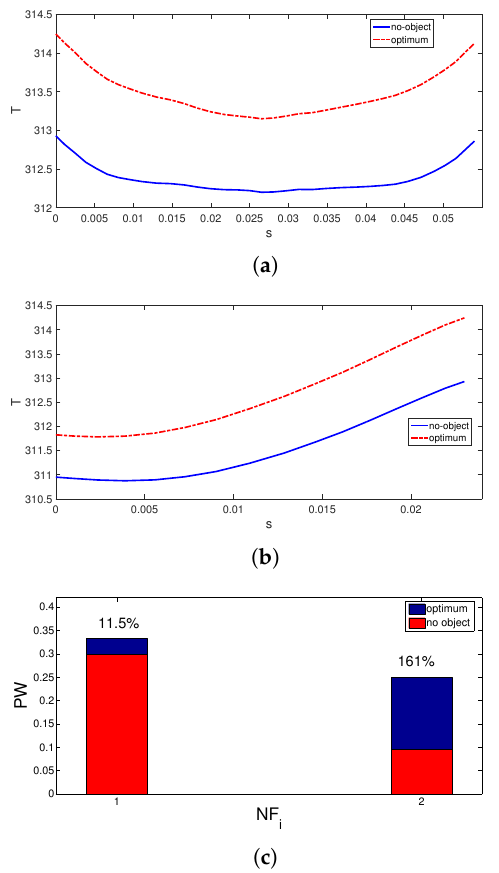
Figure 12. Comparison of the IT distributions in the x ( a ) and y ( b ) directions. Power generation ( c ) in the case of the optimum configuration and in the case of